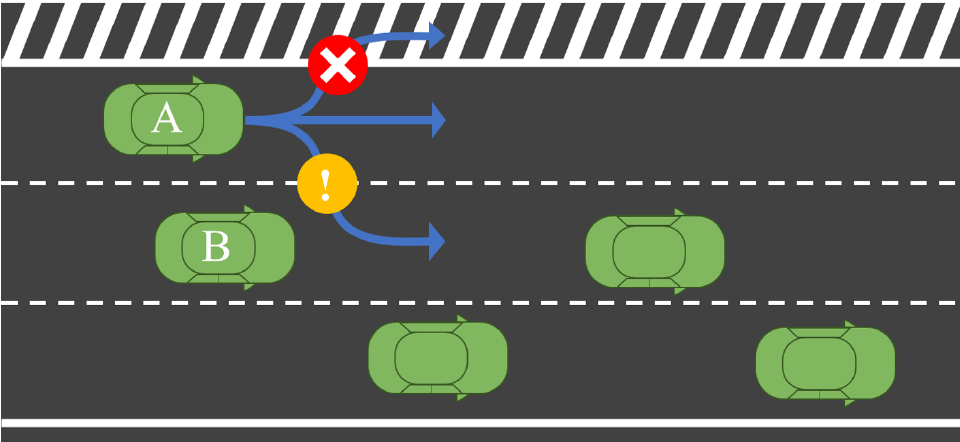
Figure 1. An example of a traffic scenario depicting the relationships between the traffic infrastructure and traffic